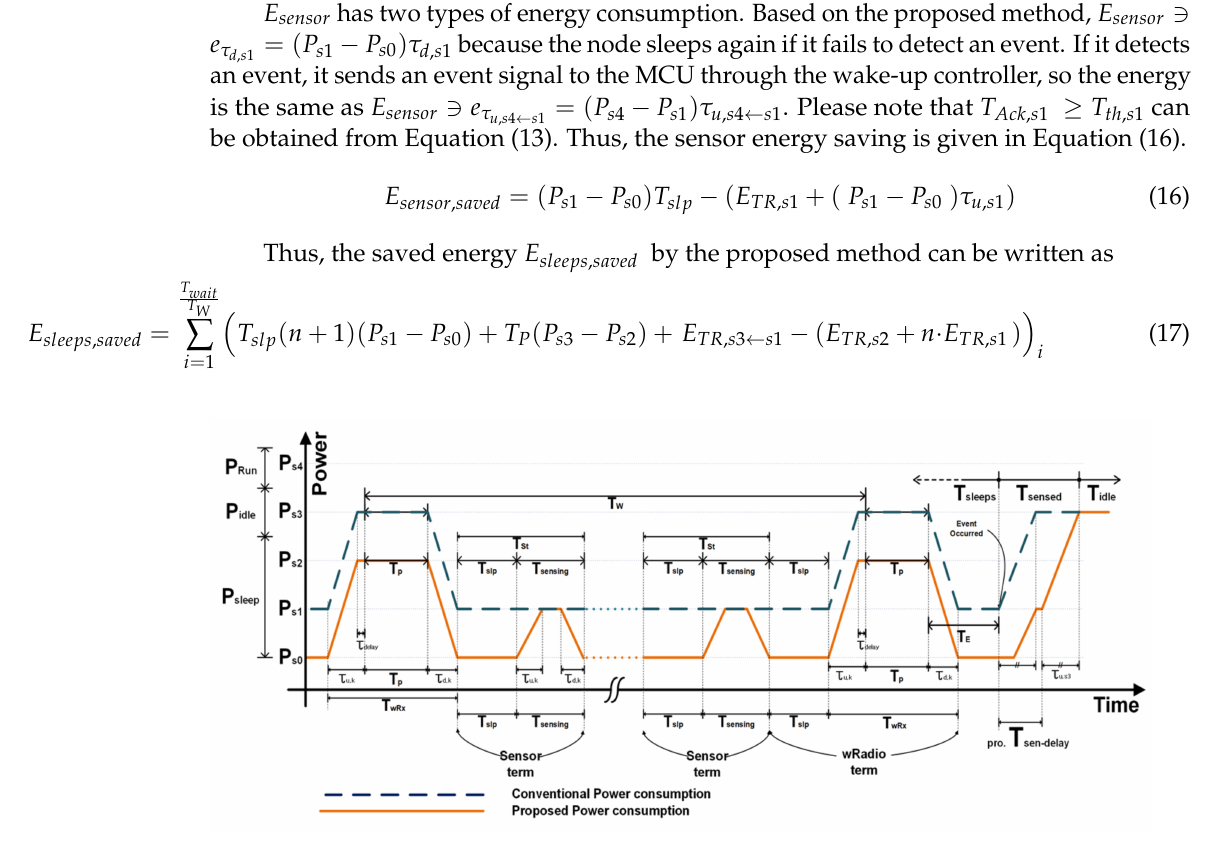
Figure 9. Transforming of energy states in sleep mode of a